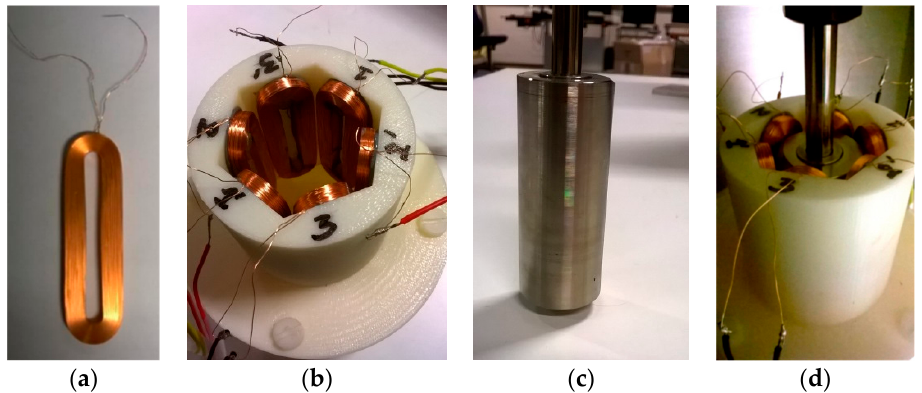
Figure 5. Picture of ( a ) One stator coil, ( b ) the stator, ( c ), the rotor, and ( d ) the centering heteropolar electrodynamic bearing prototype, investigated for its torque generation and self-centering capacities. Table 1. Characteristics of the prototype.